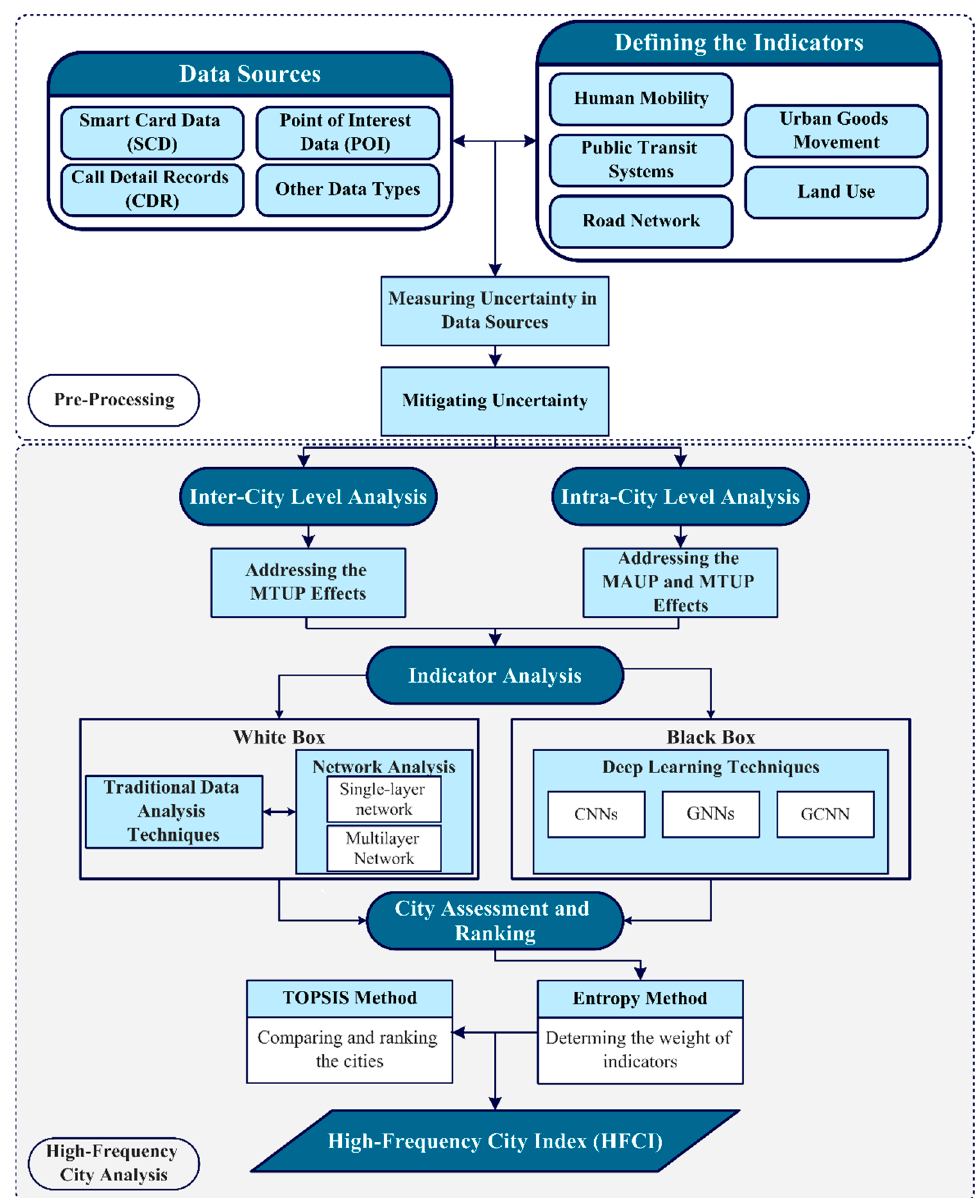
Figure 3. The methodological framework for the evaluation of the high-frequency city.